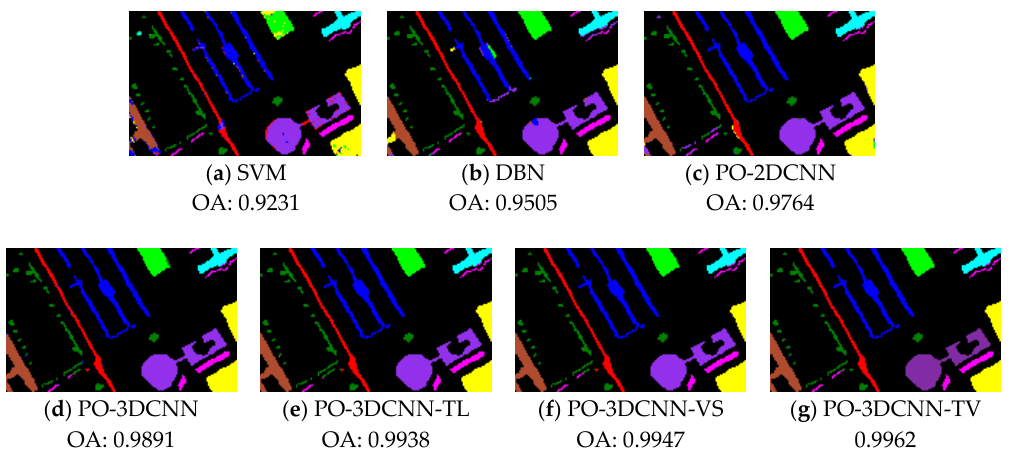
Figure 10. Classification of the part-PaviaU HSI.